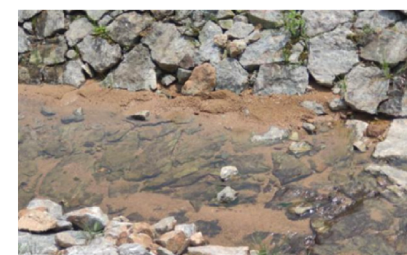
Figure 2: Photos of the dam